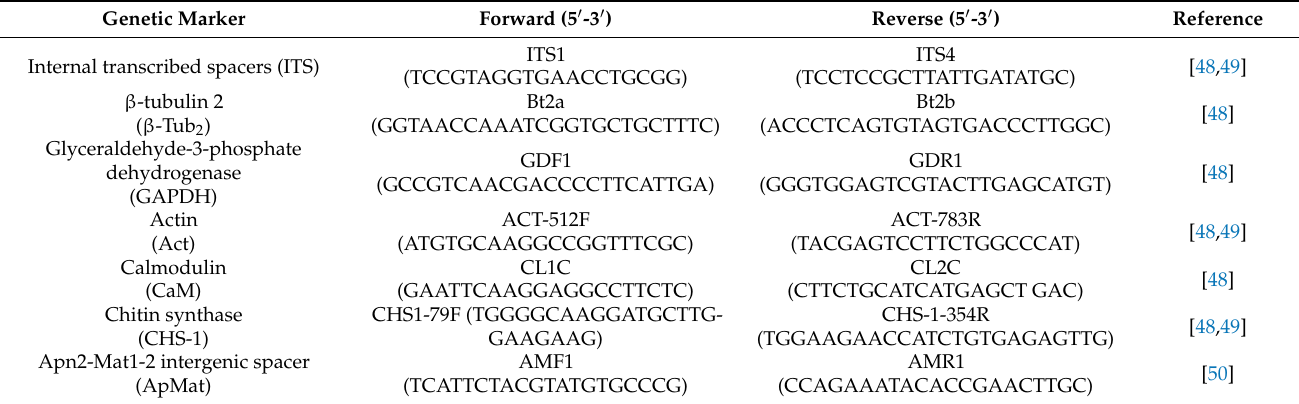
Table 4. Primer sequences for identification of fungal